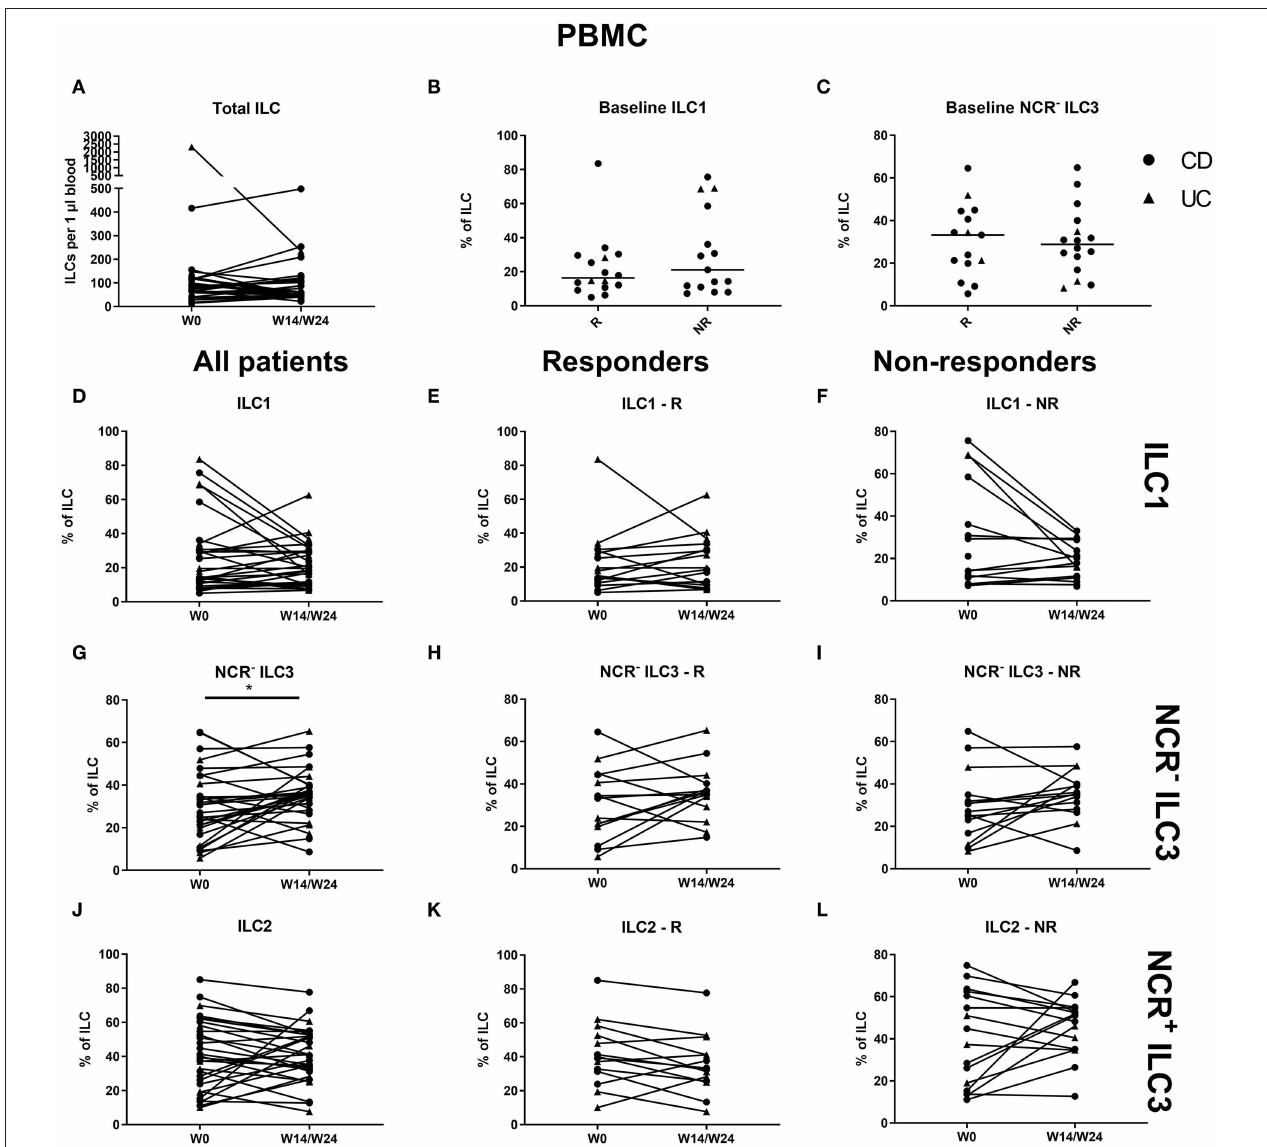
FIGURE 8 | Changes in circulating ILC and ILC subpopulations during vedolizumab therapy. Thirty-two patients initiating vedolizumab treatment were followed up for 14 (UC, 1 )/24 (CD, • ) weeks and subdivided into responders (R, n = 14) and nonresponders (NR, n = 18) based on endoscopic evaluation. Total ILC expressed as cells per microliter of full blood in all patients (A) . Baseline ILC1 (B) and NCR − ILC3 (C) levels in R and in NR. Follow-up of circulating ILC1 in all patients (D) , in R (E) and in NR (F) . Follow-up of circulating NCR − ILC3 in all patients (G) , R (H) and NR (I) . Follow-up of circulating ILC2 in all patients (J) , in R (K) and in NR (L) . Mann–Whitney U testing (B,C) ; Wilcoxon paired-match testing (A,D–L) ; * p < 0.05. NCR, natural cytotoxic receptor; ILC, innate lymphoid cell; CD, Crohn disease; UC, ulcerative